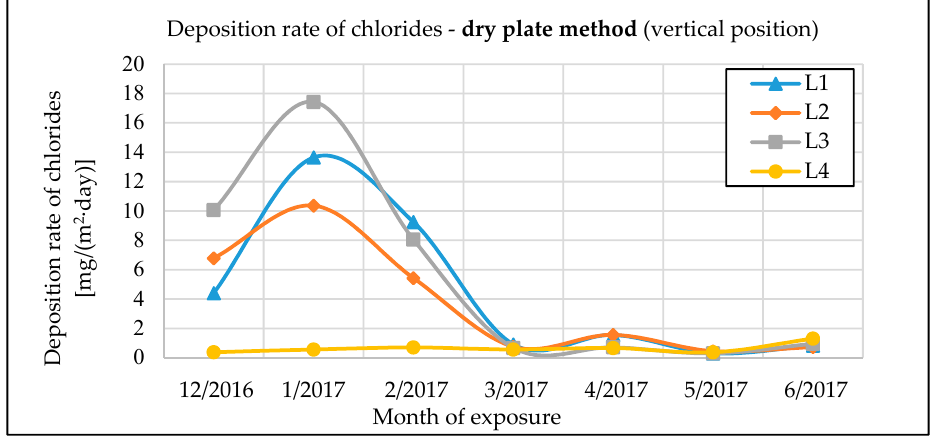
Figure 10. The chloride deposition rates determined by the dry horizontal plate method.